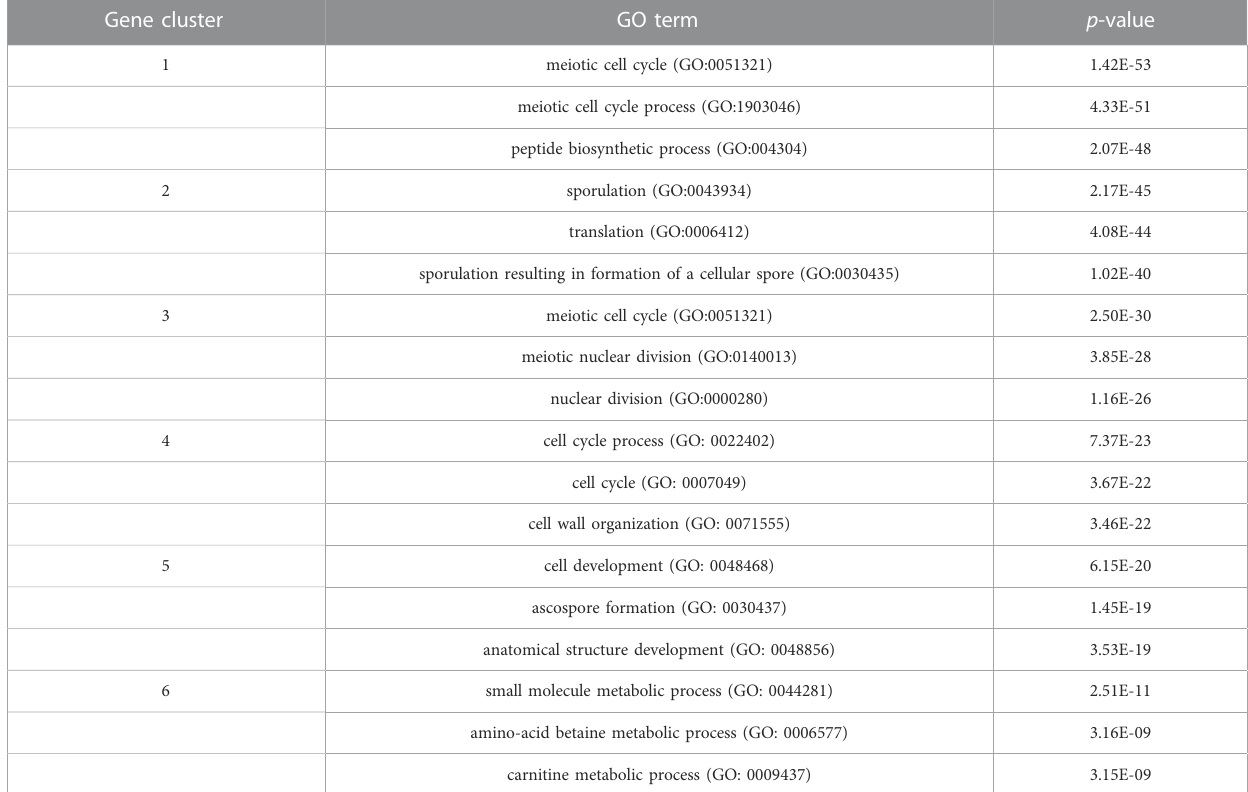
TABLE 7 The three most signi fi cant GO terms and the corresponding p -values for each of the six clusters obtained by MSC-CSMC on Yeast Sporulation. Gene cluster GO term p